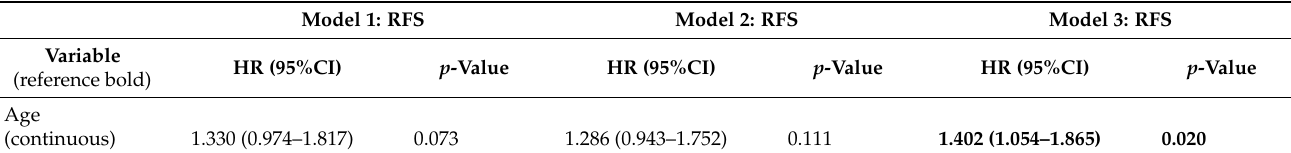
Table 2. Multivariate Cox regression analysis for recurrence-free survival (RFS) either with C-reactive protein (CRP), lymphocyte-to-monocyte ratio (LMR) or neutrophil-to-lymphocyte ratio (NLR).